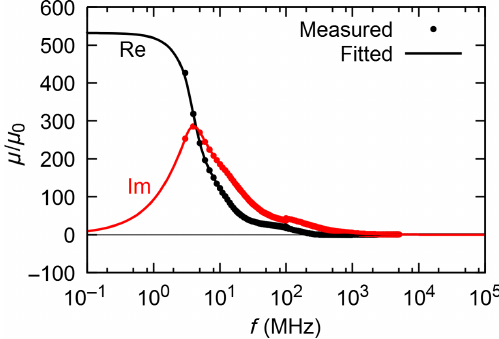
FIG. 11. Simulation geometry of test accelerating gap for ETA- II [12]. Damping ferrite is shown in red. Adapted from Fig. 1 in Ref. [12].